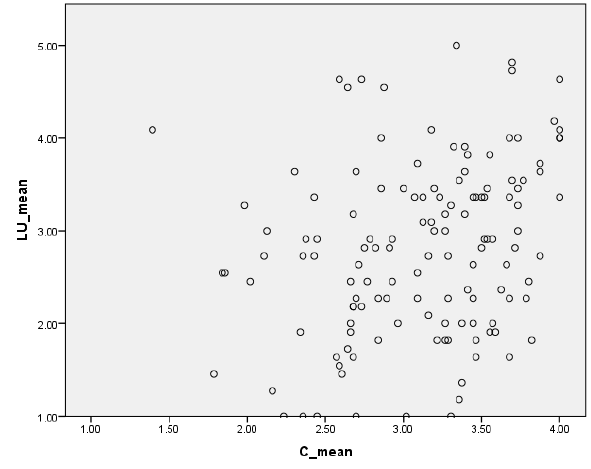
Figure 1. Distribution of Teachers’ Laptop Use and